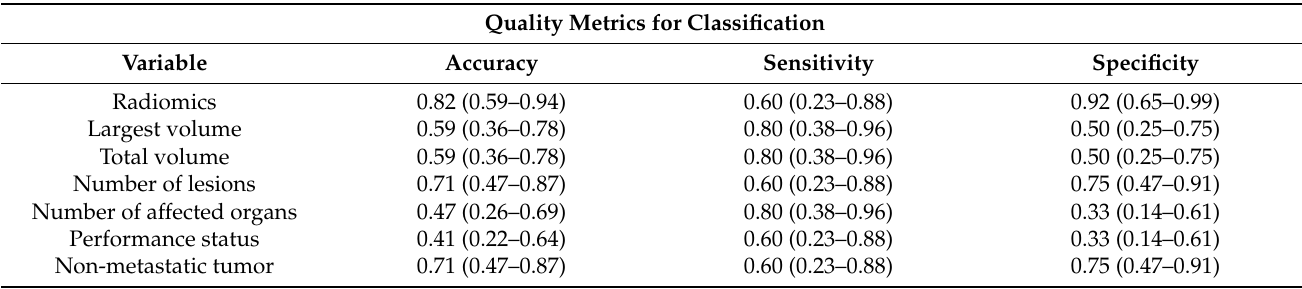
Figure 4. Confusion matrices for the clinical variables considered for the NIVACTOR project. ( A ) Volume of the largest Region Of Interest (ROI). ( B ) Total tumor volume. ( C ) Number of affected organs. ( D ) Number of lesions. ( E ) Performance status. ( F ) Non-metastatic status. Table 2. Performance of the different variables in the prediction of long term survival (OS > 10